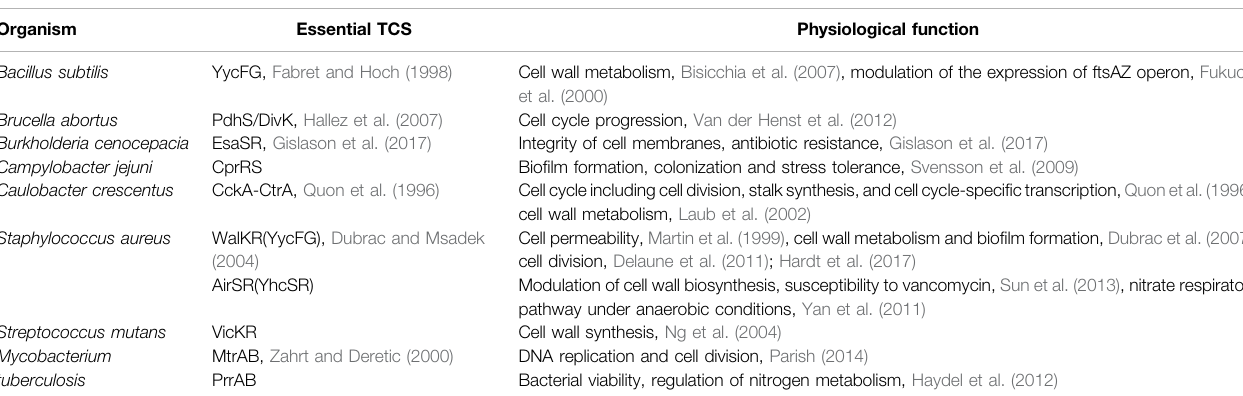
TABLE 2 | Essential TCSs in bacteria (Cardona et al., 2018).